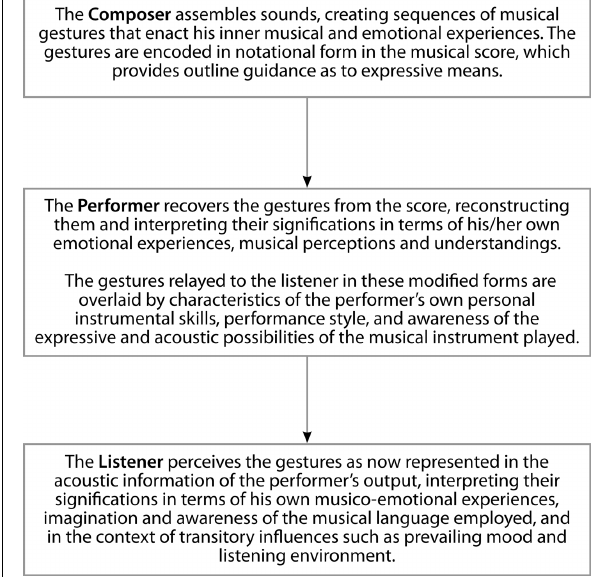
FIGURE 1 | The triadic transfer of music